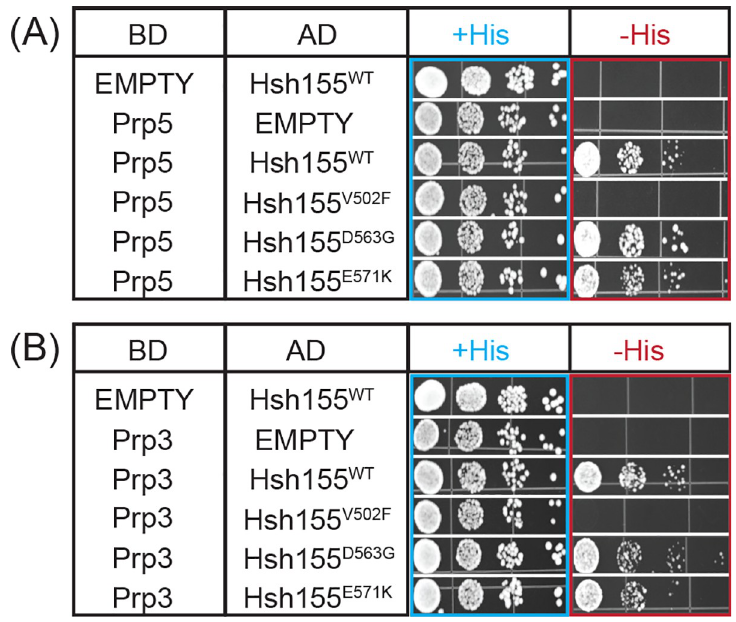
Fig 6. Yeast two-hybrid assay for interactions between Hsh155, Prp5, and Prp3. Hsh155 WT or LBU-mutant proteins were fused to the AD of the two-hybrid reporter and either Prp5 (A) or Prp3 (B) were fused to the reporter BD. +His represents non-selective media containing histidine. -His represents selective media lacking histidine in which growth indicates a two-hybrid interaction. Each two-hybrid assay was repeated three times.